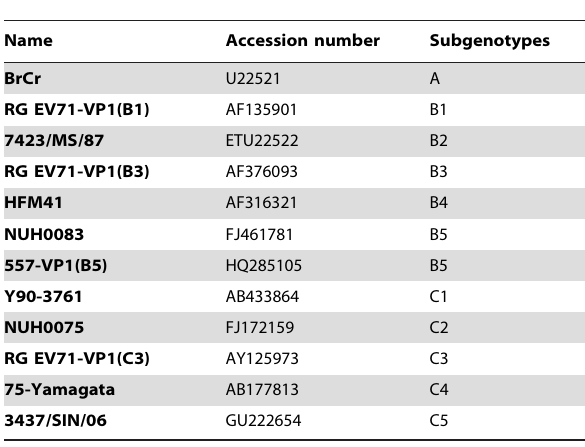
Table 1. EV71 viruses used in this